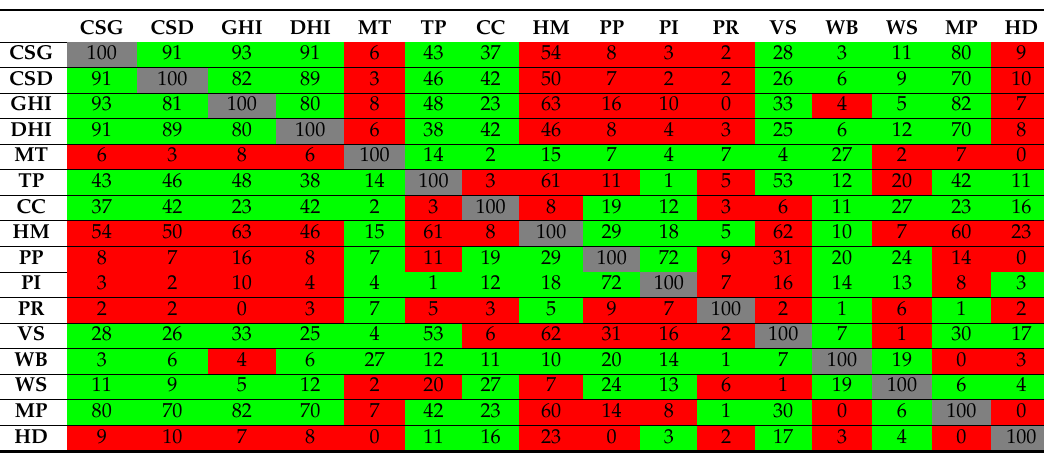
Table 2. Pearson’s correlation of different attributes over the whole observation time presented in percent. For the symbols and their definition, see Table 3.